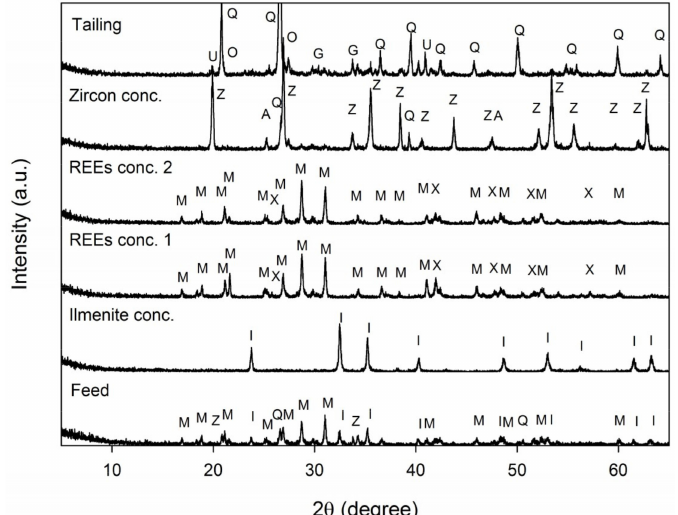
Figure 7. X-ray diffraction patterns of beneficiation process products. A—Anatase; G—Grossular; I—Ilmenite; M—Monazite; O—Orthoclase; Q—Quartz; U—Muscovite; X—Xenotime;